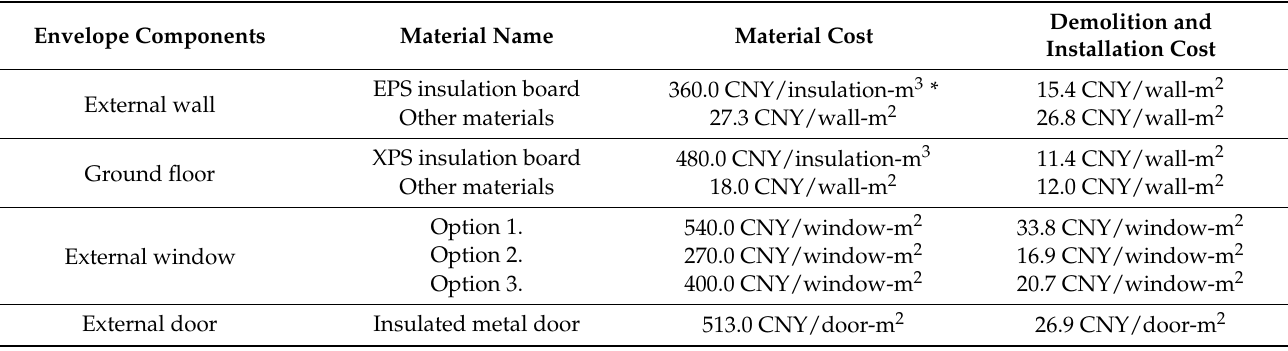
Figure 4. Main processes of SBMO with IDA ICE and AutoMOO in this study. Table 4. Cost data of envelope renovation